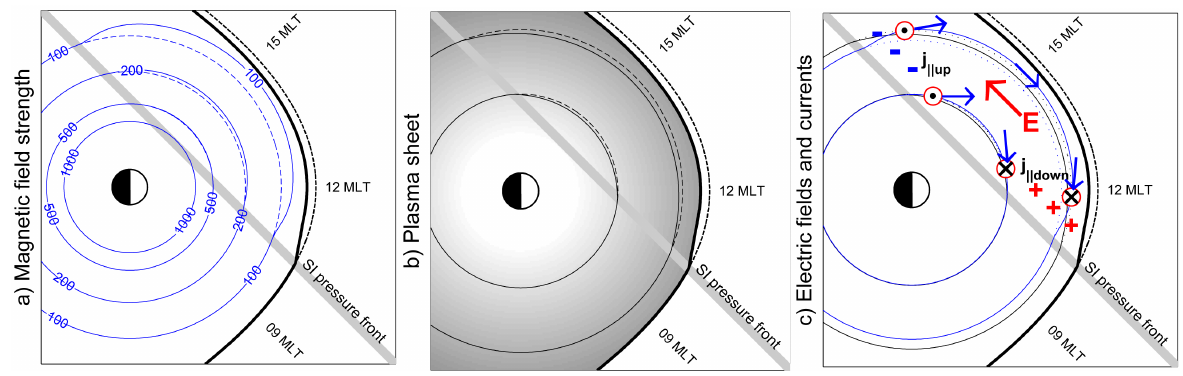
Fig. 8. Sketches showing propagation of the pressure disturbance in the equatorial plane of the magnetosphere and generation of the eastward electric field. Thick gray line represents the pressure front approaching the Earth in the 15 MLT sector. ( a ) The pulse-related magnetic field intensity distribution. Behind the pressure front, the magnetic field is increased so that the contours of constant magnetic field (blue lines) shift away from the Earth, from the positions indicated by dashed lines to the new positions shown by solid lines. ( b ) Distribution of the hot magnetospheric plasma density. The plasma, together with the magnetic flux tubes, moves toward the Earth in the equatorial plane because of the induced electric field. This results in the magnetospheric plasma boundaries’ (e.g. indicated by black contour lines) motion toward the Earth, from the positions indicated by dashed lines to the new positions shown by solid lines. ( c ) The magnetic field intensity contours and the plasma boundaries move in the opposite directions. As the contours move, the angle between the plasma boundaries (black contours) and the B = const lines (blue contours) changes. In those parts of the space where the B = const contours cross the plasma boundaries, polarization electric charges, electric fields, and field-aligned currents are generated with the directions as indicated on the